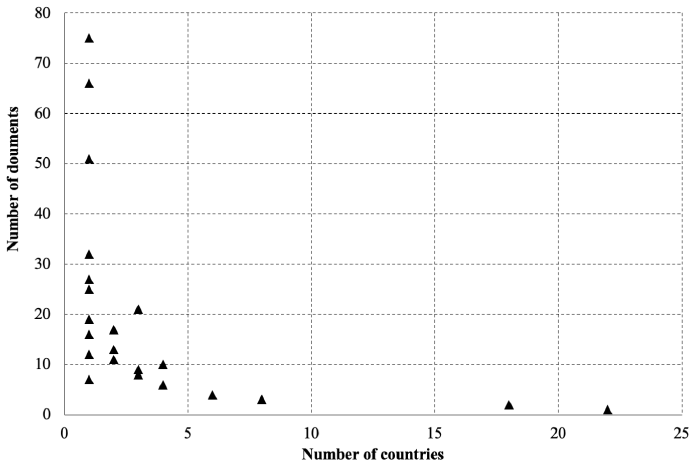
Figure 5. Relationship between the number of countries and the number of documents published.